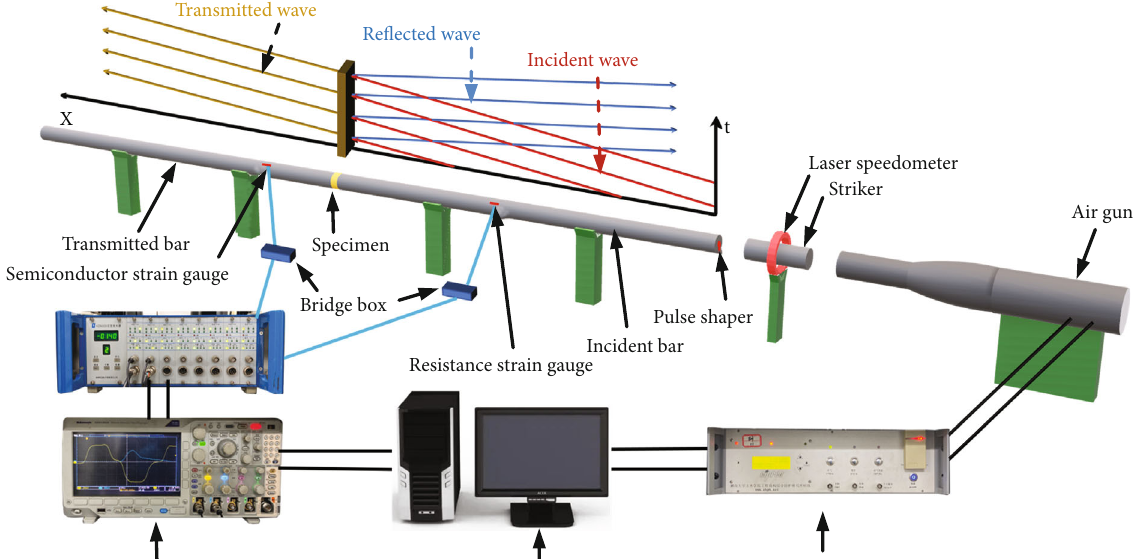
Figure 2: SHPB device.